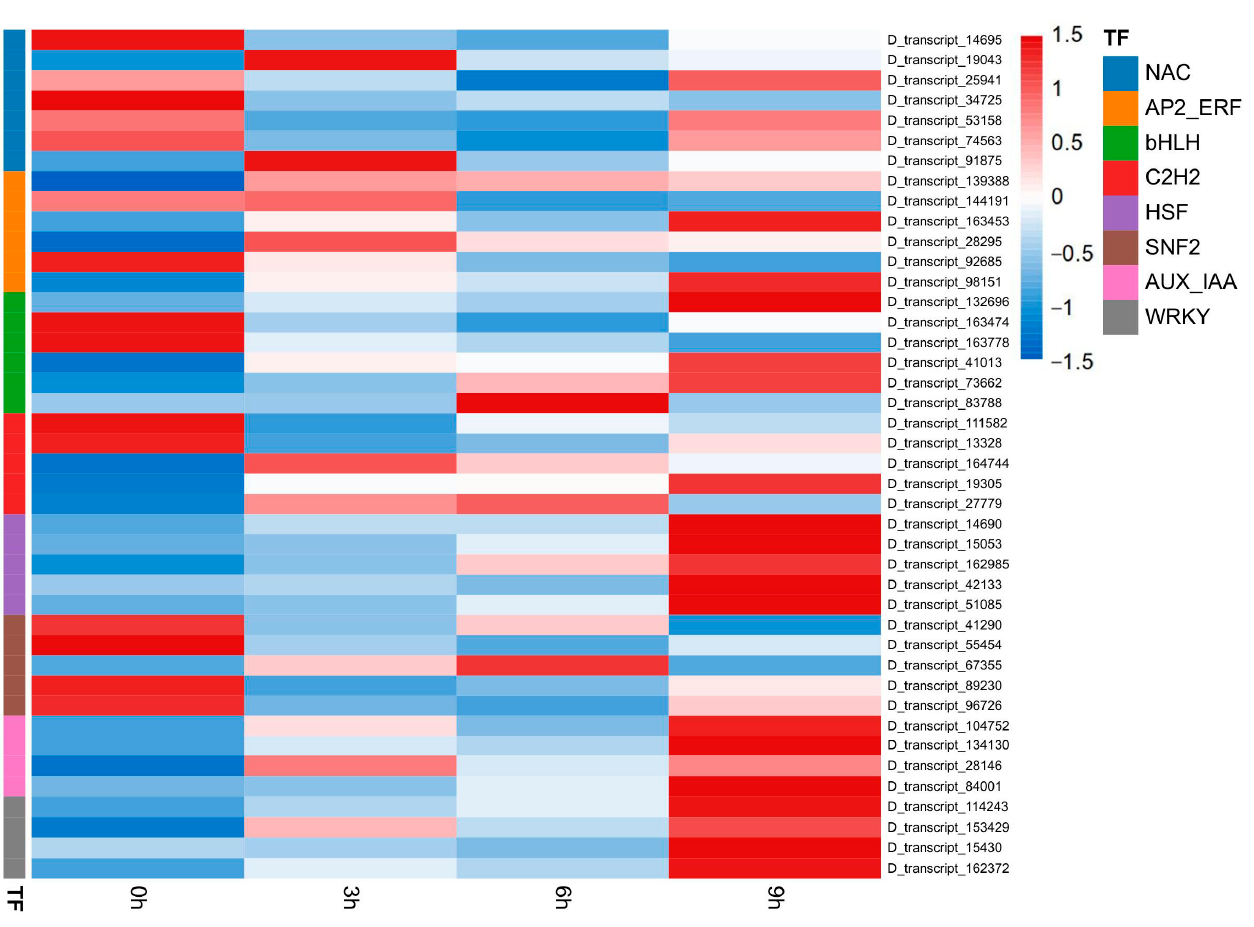
Figure 6. TF and TR expression profiles between centipedegrass samples under low-temperature stress based on FPKM values. Red and blue indicate high and low expression levels,